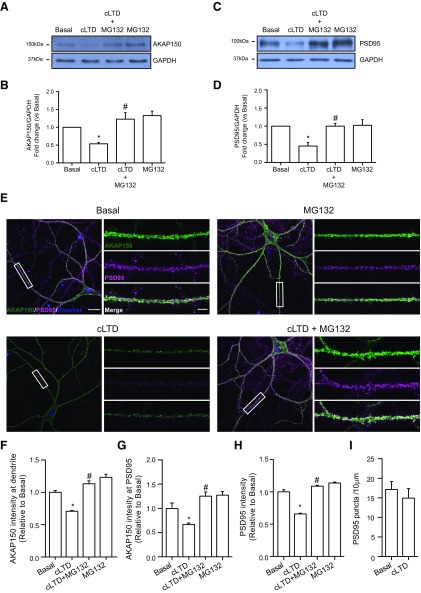
cLTD-mediated reduction of AKAP150 requires proteasome activity. A, Representative blot images showing the effect of proteasome inhibitor MG132 (10 μM) on AKAP150 protein levels after cLTD (top panel) related to GAPDH (bottom panel) used as loading control. B, Quantification of AKAP150 changes in response to NMDA stimulation in presence of MG132 compared with cLTD (for n = 4, *p = 0.0125 vs basal and #p = 0.0014 vs cLTD). C, Representative blot images showing the effect of proteasome inhibitor MG132 (10 μM) on PSD95 protein levels after cLTD (top panel) related to GAPDH (bottom panel) used as loading control. D, Quantification of PSD95 changes in response to NMDA stimulation in presence of MG132 compared with cLTD (for n = 3, *p = 0.0092 vs basal and #p = 0.0091 vs cLTD). E, Representative confocal images of primary neurons showing AKAP150 (green), postsynaptic marker PSD95 (magenta) and nuclei (blue) staining. Separated color panels for individual marker from the boxed regions have been magnified for dendrite clarity (right panels). Lower right panels show the merge for AKAP150 (green)/PSD95 (magenta), where cLTD reduced dendritic and synaptic intensity in AKAP150 staining. The presence of MG132 (10 μM) blocks this reduction. F, Quantification of AKAP150 intensity at dendrites. cLTD reduced AKAP150 dendritic intensity and the presence of MG132 avoids this reduction (n > 15 dendrites of different neurons from four independent cultures, *p < 0.0001 vs basal; #p < 0.0001 vs cLTD). G, Quantification of AKAP150 intensity at the PSD95. cLTD reduction of synaptic AKAP150 intensity was blocked by MG132 (n > 50 puncta from >15 dendrites from four independent cultures, *p = 0.0150 vs basal; #p < 0.0001 vs cLTD). H, Quantification of PSD95 intensity at dendrites. cLTD reduction of PSD95 intensity was blocked by MG132 (n > 15 dendrites of different neurons from four independent cultures, *p = 0.0005 vs basal; #p = 0.0002 vs cLTD). I, Quantification of PSD95 puncta at dendrites normalized to basal. There is no difference in puncta number between basal and cLTD conditions (n > 50 puncta from >15 dendrites from four independent cultures). Scale bars = 20 μm (A, left panels) and 5 μm (A, right panels). Bars represent mean ± SEM.